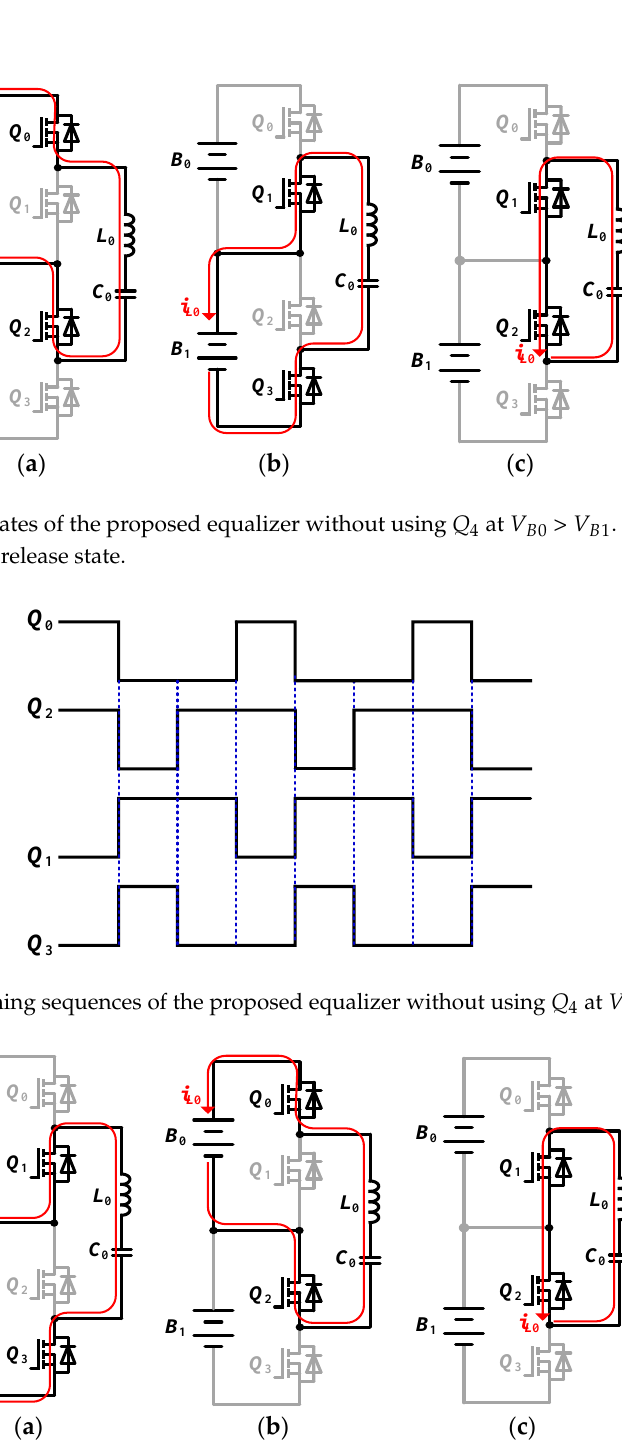
Figure 10. Operating states of the proposed equalizer without using Q 4 at V B 0 < V B 1 . ( a ) charge state; ( b ) discharge state; ( c ) release state.